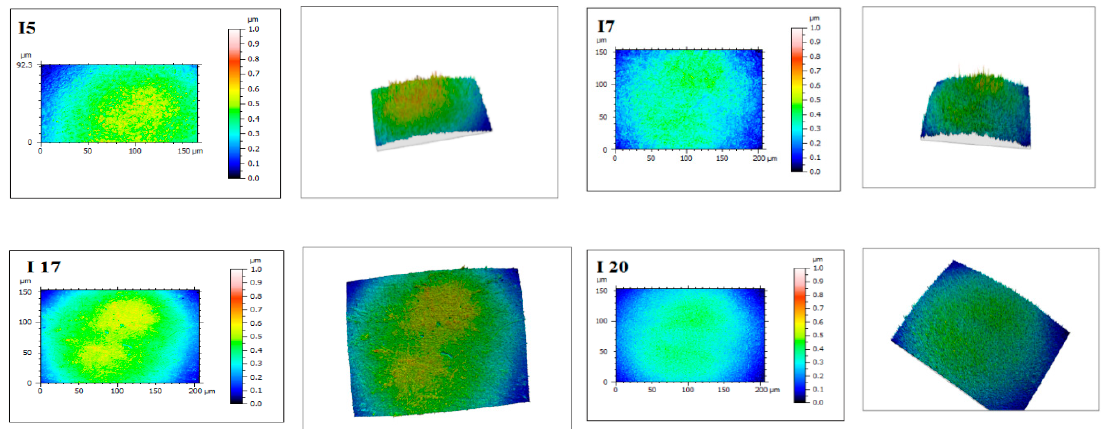
Figure 3. Microscopic structures and reflectivity of films’ surfaces.